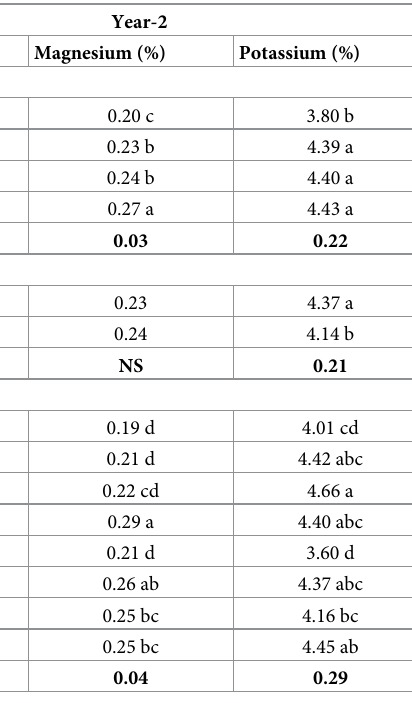
Means followed by similar letters within a column are statistically non-significant (p > 0.05). NS =